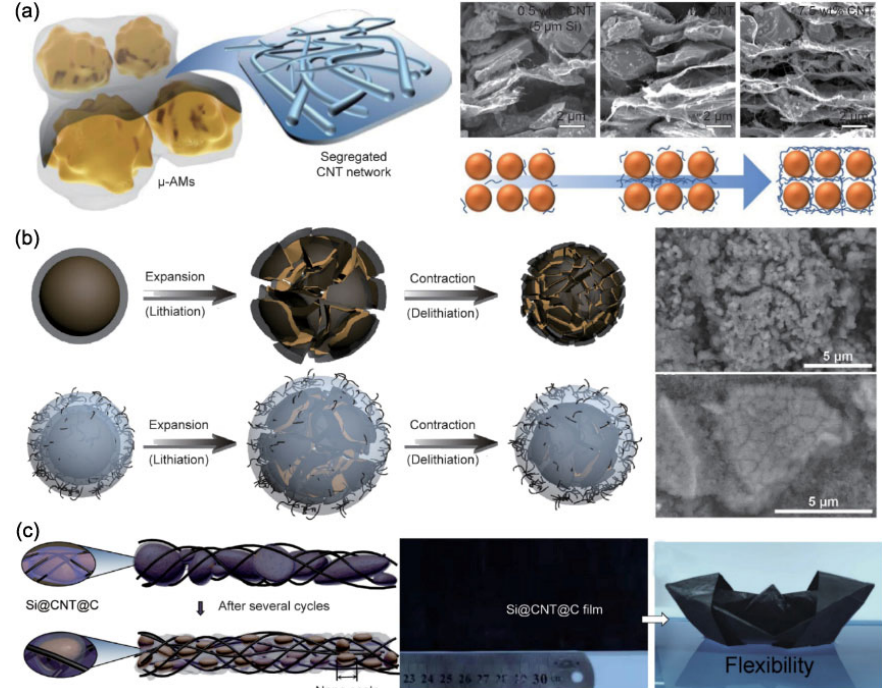
Figure 6 (a) Schematic illustration for the hierarchical Si/CNT segregated network composite electrode. Reproduced with permission from Ref. [111], © Park, S. H. et al. under exclusive licence to Springer Nature Limited 2019. (b) Schematic illustration of the lithiation and delithiation of SiO x /C and C-SiO x /C. Reproduced with permission from Ref. [112], © Elsevier Ltd. 2020. (c) Structural characteristics of the Si@CNT@C film. Reproduced with permission from Ref. [114], © Elsevier Ltd. 2021.